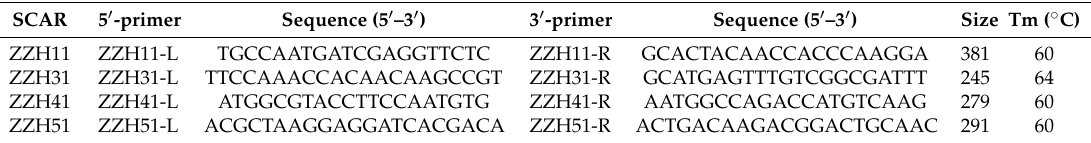
Table 2. Sequences of SCAR primers, PCR condition and product size